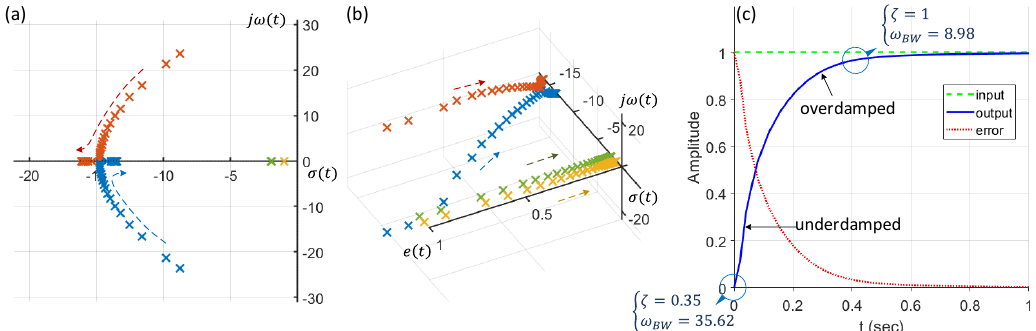
Figure 15. Dynamic pole motion of the controlled compensated hybrid soft leg and the system response by error change with the gains of K pf = 210, K vf = 31, α = 2, and β = 0.5: ( a ) 2D plot, ( b ) 3D plot, and ( c ) the system response to the step input ( ζ : damping ratio and ω BW : bandwidth in Hz). The arrows in ( a , b ) indicate the direction of pole motions.